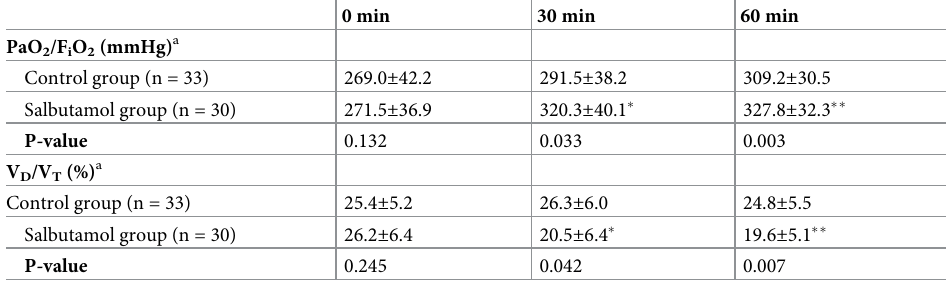
Data are presented as the mean ± standard deviation. F i O 2 , fraction of inspired oxygen; PaO 2 , arterial partial pressure of oxygen; V D , dead space volume; V T , tidal volume. � p < 0.05 and �� p < 0.01 vs. the control